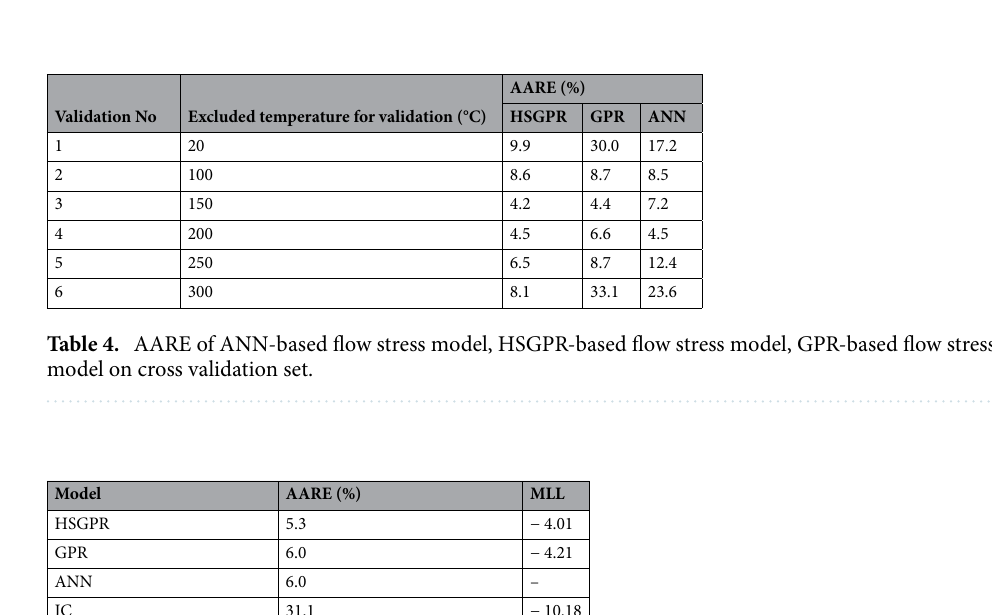
Table 3. AARE and MLL of ANN model, HSGPR-based flow stress model and GPR-based flow stress model on the training and testing dataset.